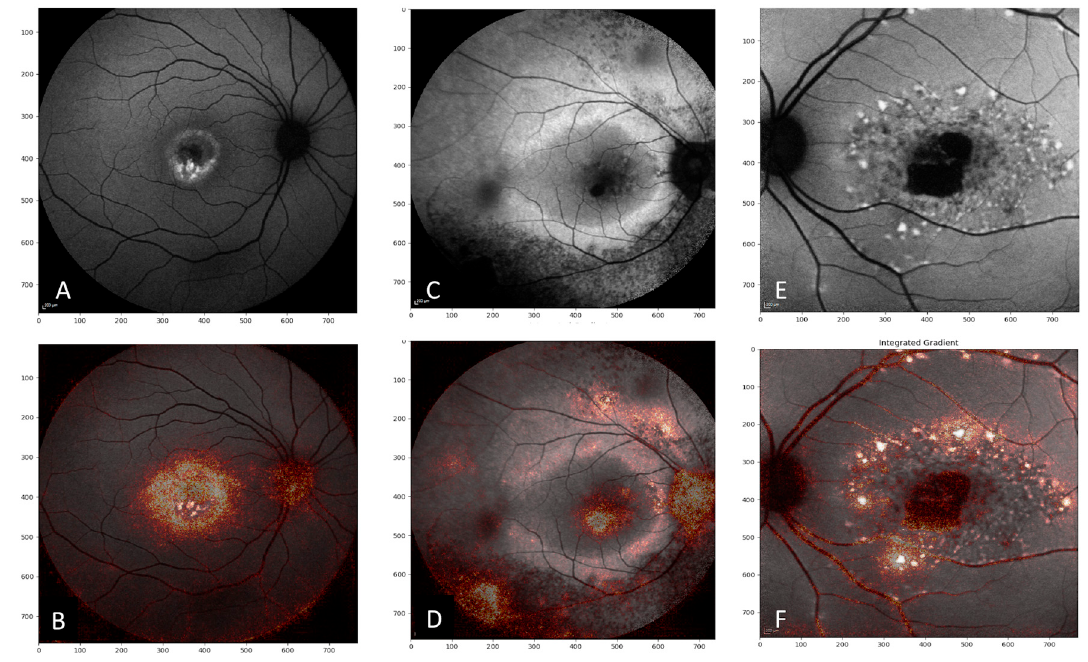
Figure 3. Fundus autofluorescence (FAF) images (upper panels) of correct attribution with integrated gradient visualization (lower panels): ( A ) FAF image of Best vitelliform macular dystrophy, correctly classified by the deep learning model; ( B ) integrated gradient visualization reflects distinctive features (in this case, the presence of hyperautofluorescent vitelliform deposit) of the input image; ( C ). FAF image of retinitis pigmentosa, correctly classified by the deep learning model; ( D ). integrated gradient visualization reflects distinctive features (in this case, the presence of hyperautofluorescent ring) of the input image; ( E ) FAF image of Stargardt disease, correctly classified by the deep learning model; and ( F ) integrated gradient visualization reflects distinctive features (in this case, the presence of hyperautofluorescent flecks and centra atrophy) of the input image.